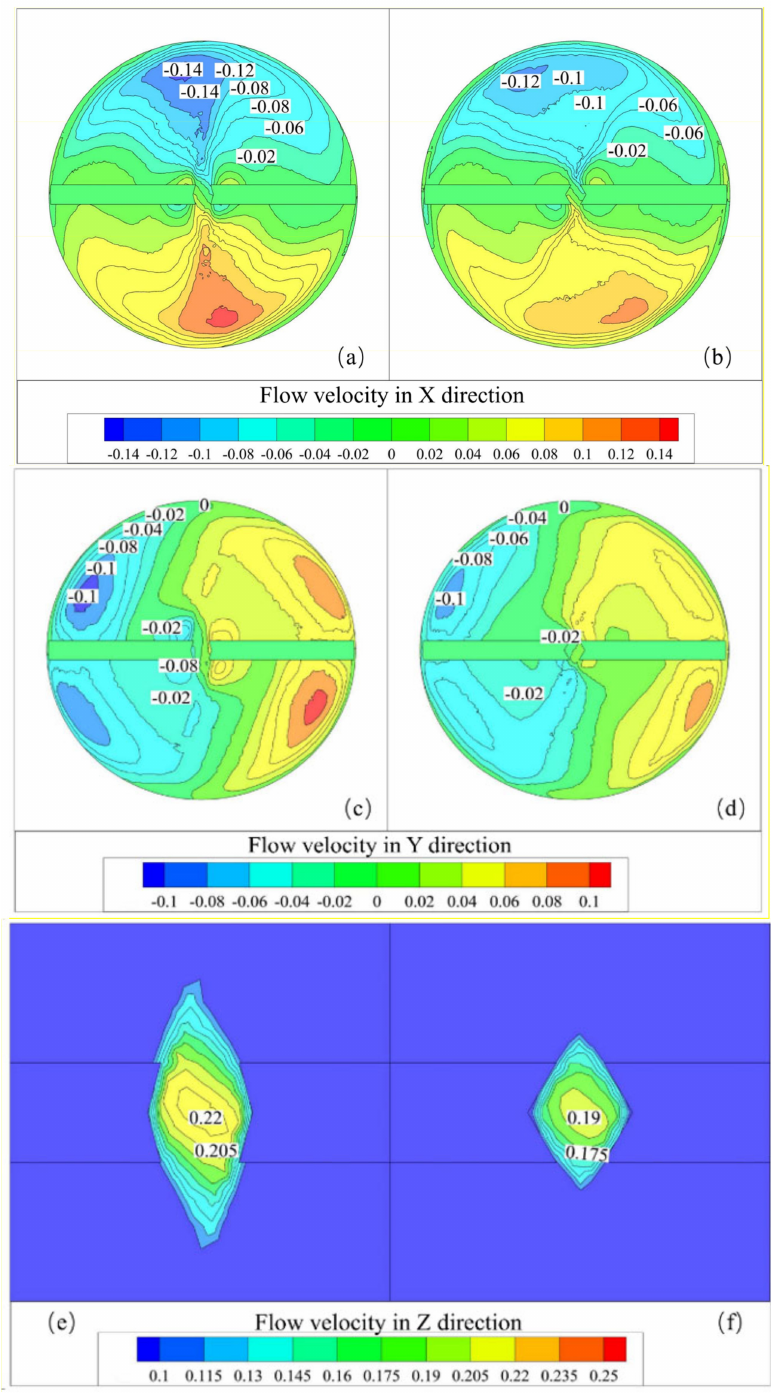
Figure 13. Fluid velocity components in three directions: ( a ) 105 ◦ outer angle, X − axis velocity component; ( b ) 120 ◦ outer angle, X − axis velocity component; ( c ) 105 ◦ outer angle, Y − axis velocity component; ( d ) 120 ◦ outer angle, Y − axis velocity component; ( e ) 105 ◦ outer angle, Z − axis velocity component; ( f ) 120 ◦ outer angle, Z − axis velocity